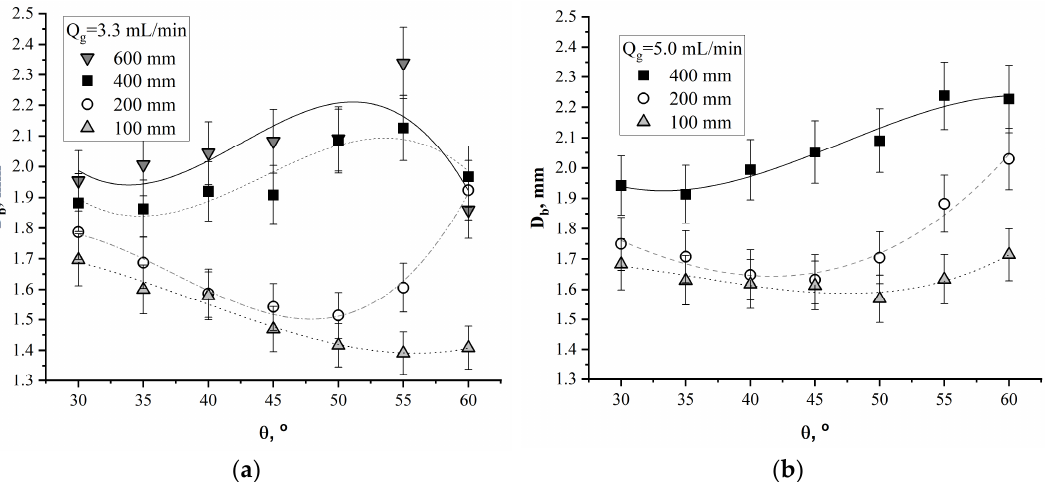
Figure 7. Dependence of the average size of gas bubbles as a function of the pipe inclination angle. Gas flow rate ( a ) Q g = 3.3 mL/min; ( b ) Q g = 5.0 mL/min.